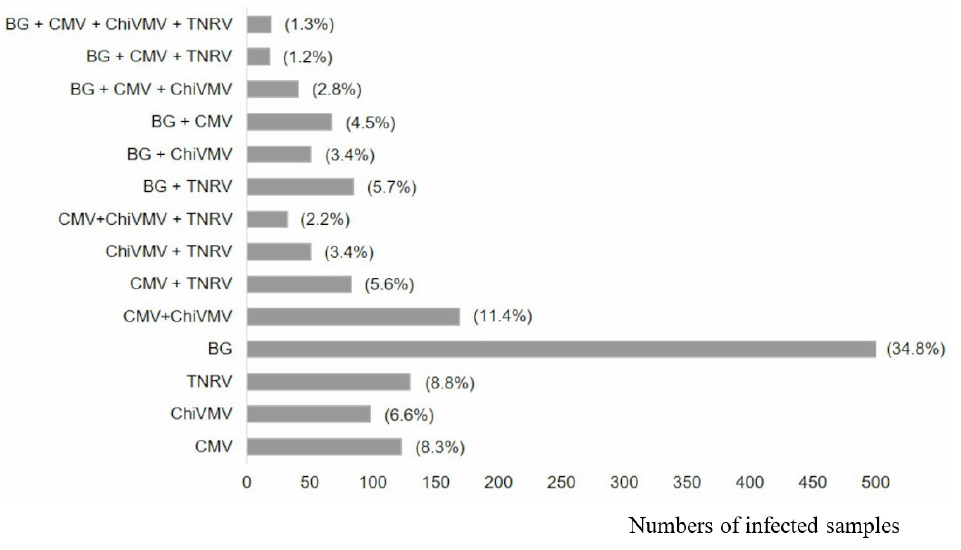
Figure 4: Incidence of the viral infections (both single and mixed infections) on pepper plants. BG = Begomovirus; CMV = Cucumber mosaic virus, ChiVMV = Chilli veinal mottle virus; and TNRV = Tomato necrotic ringspot virus. The percentage values of the virus incidence were calculated from the total infected samples of 1,482, and shown in parentheses.